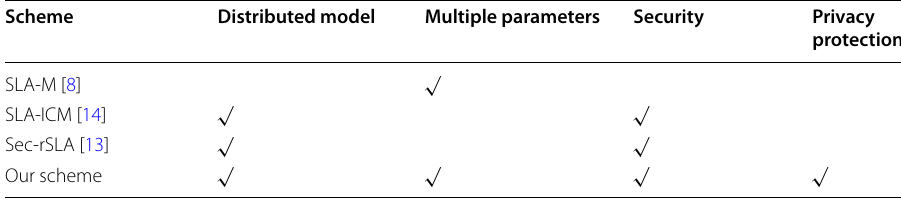
Table 2 Comparison of SLA audit schemes Scheme Distributed model Multiple parameters Security Privacy